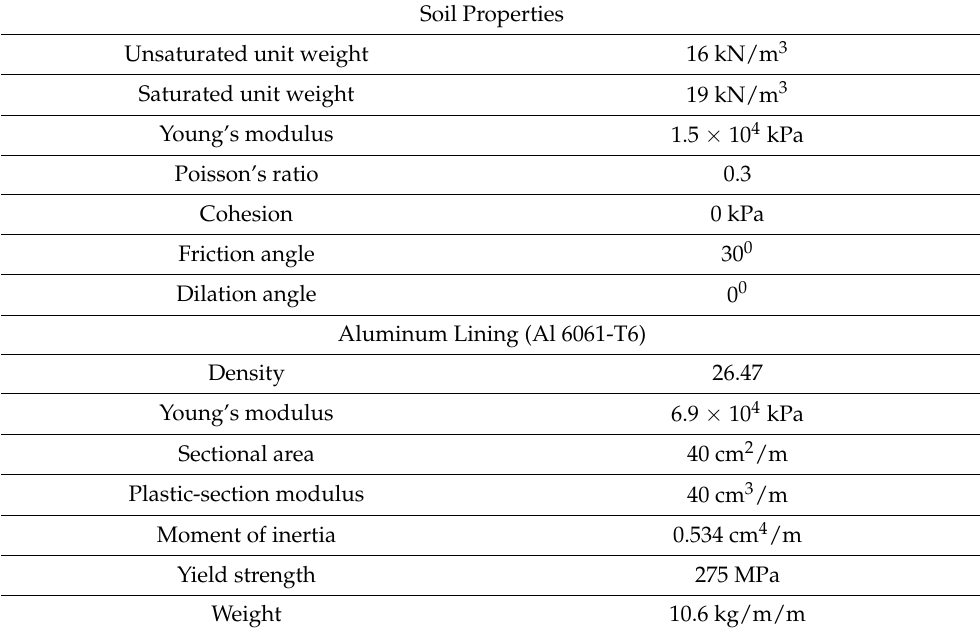
Table 1. Properties of soil and aluminium lining.